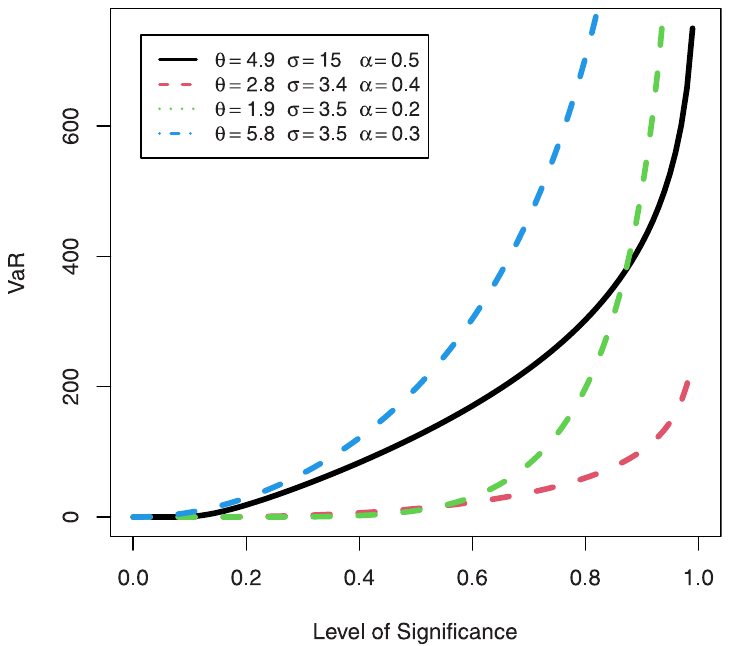
Fig 15. Plots of the VaR of EGuNH distribution for some random parameter values.